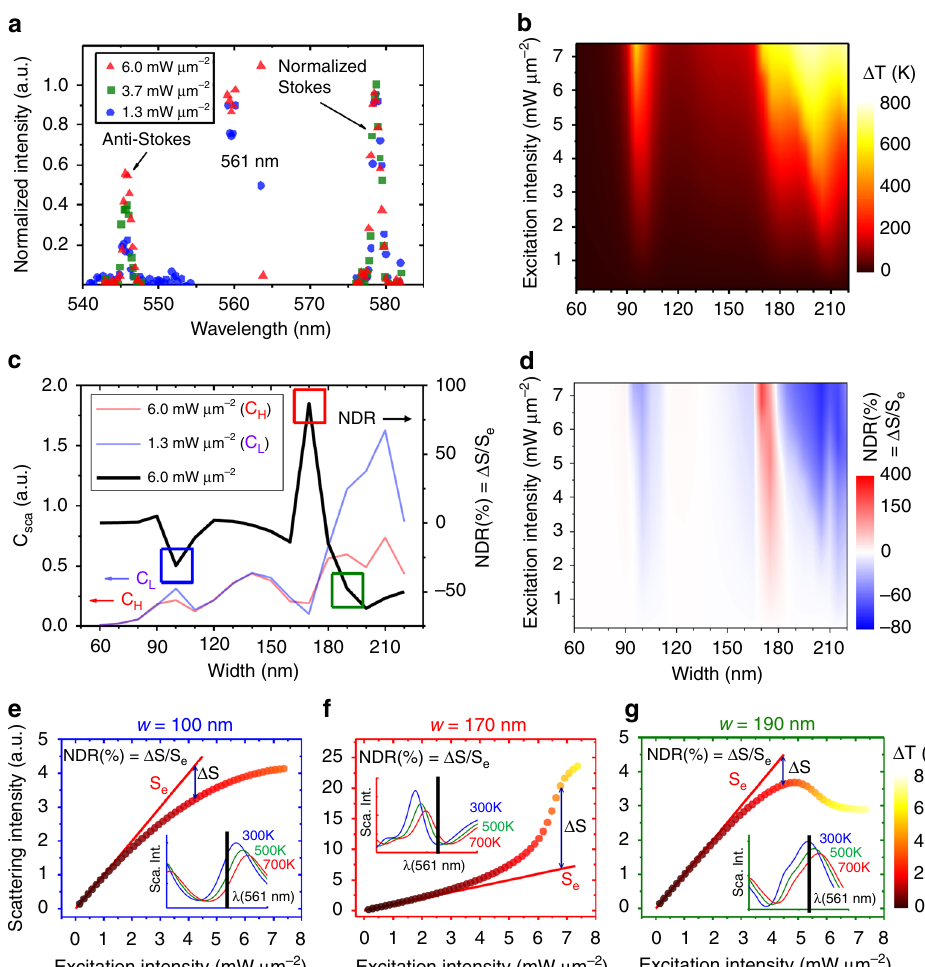
Fig. 3 Photothermal-based nonlinearity. a The temperature of an individual nanoblock (w = 190 nm) can be measured in-situ by Raman scattering. With increasing excitation intensity, the ratio of anti-Stokes versus Stokes intensity gradually increases, indicating a temperature increase up to a few-hundred Kelvin (see Methods). b Simulated temperature map of Si nanoblocks versus excitation intensity and width, indicating non-uniform heating up to ~1000 K. c Simulated 561-nm scattering cross sections at two excitation intensities (light blue C L : 1.3 mW μ m − 2 ; light red C H : 6.0 mW μ m − 2 ), and the corresponding NDR (black line, derived from C H over C L ). The size-dependent NDR agrees very well with the experimental results in Fig. 2d. d Evolution of NDR versus excitation intensity and nanoblock size. e – g Laser intensity-dependent scattering for w = 100, 170, and 190 nm nanoblocks, respectively, again agreeing very well with Fig. 2. The color of each dot indicates the equilibrium temperature under photothermal heating. The inset of each fi gure presents the corresponding resonance spectrum shift at elevated